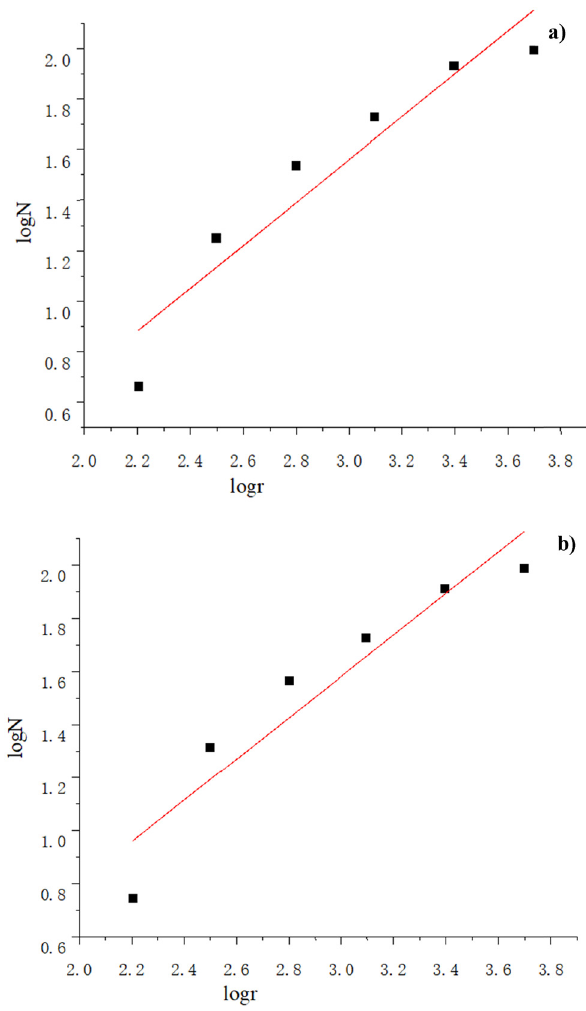
Figure 3: Double logarithmic fi tting of Type II recycled sand ( a ) , of natural sand ( b ) .